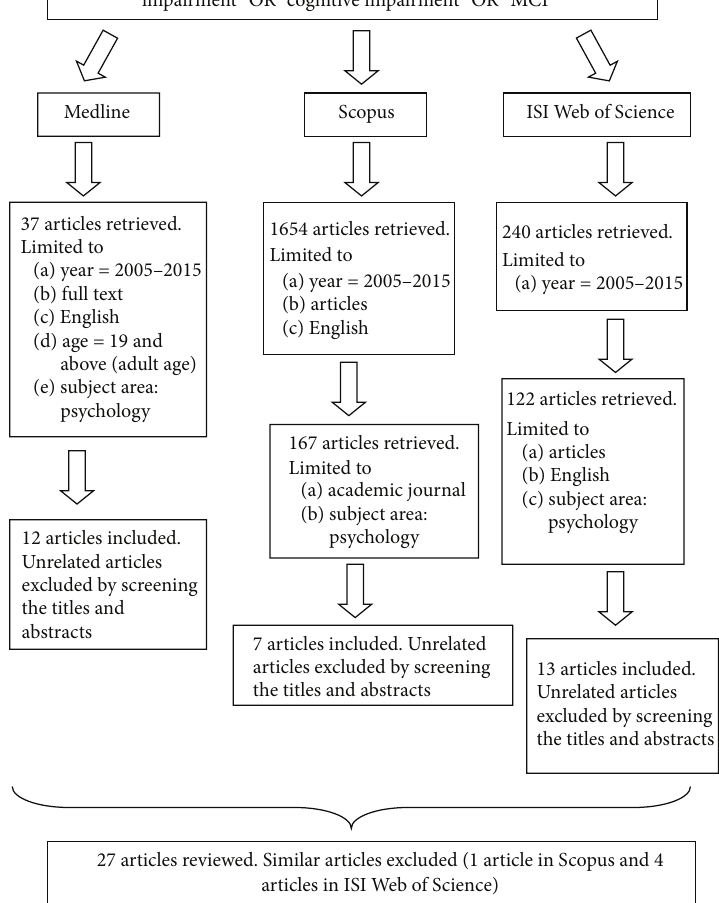
Figure 1: Flow chart of the reviewing